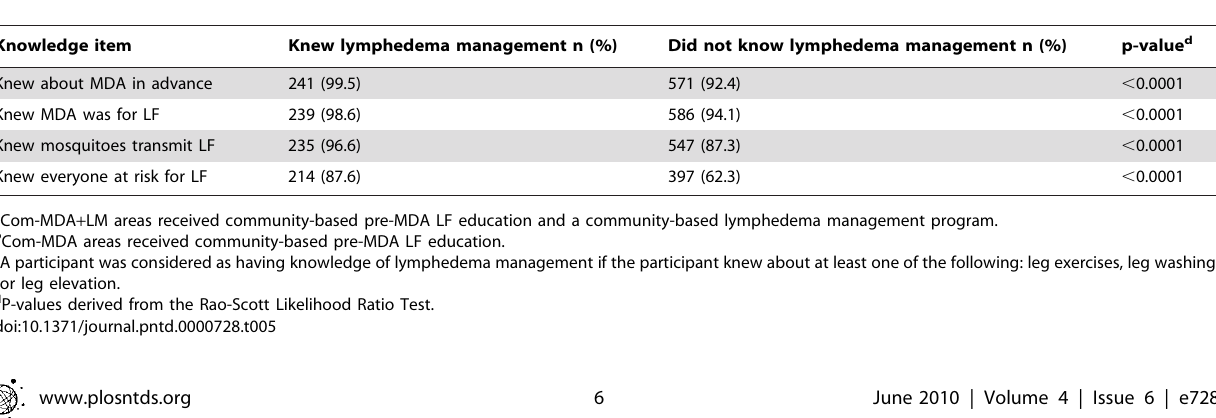
Table 5. Knowledge of univariable predictors of adherence to a DEC regimen among KAP participants from Com-MDA + LM a and Com-MDA b areas: examining the difference in knowledge based on knowledge of lymphedema management c